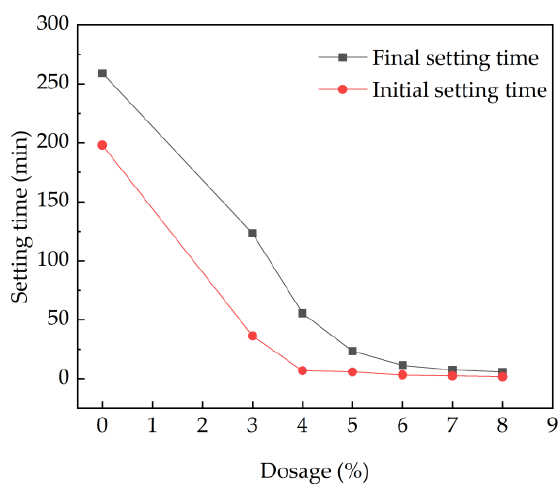
Figure 2. Effect of accelerator on the setting time of net cement paste.